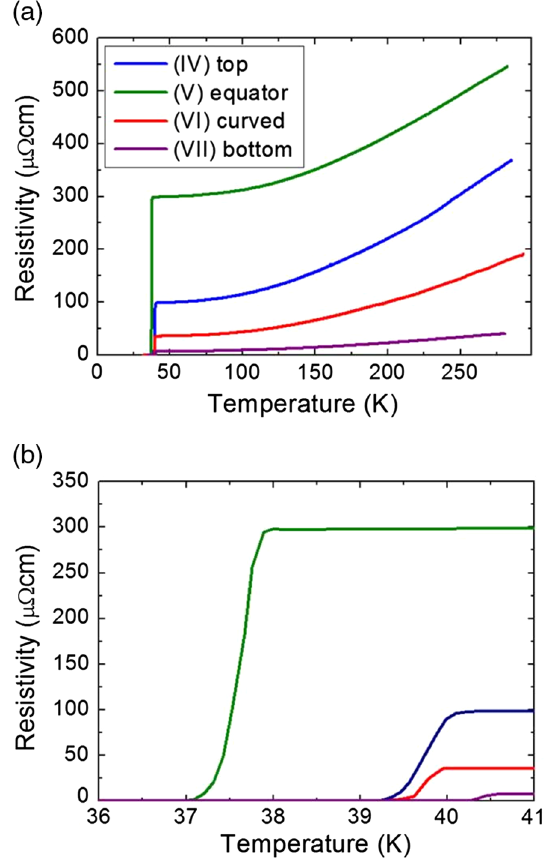
FIG. 9 (color online). (a) Resistivity versus temperature for a set of MgB 2 films at different locations of the dummy cavity. (b) Close-up of the transition edge.